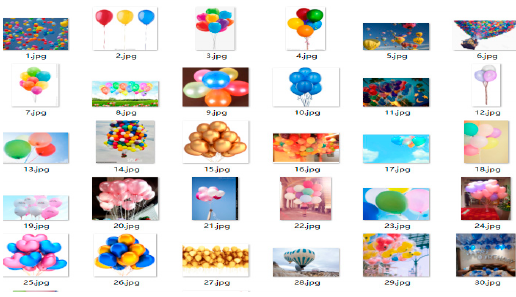
Figure 14. Rotorcraft positive specimen training set.